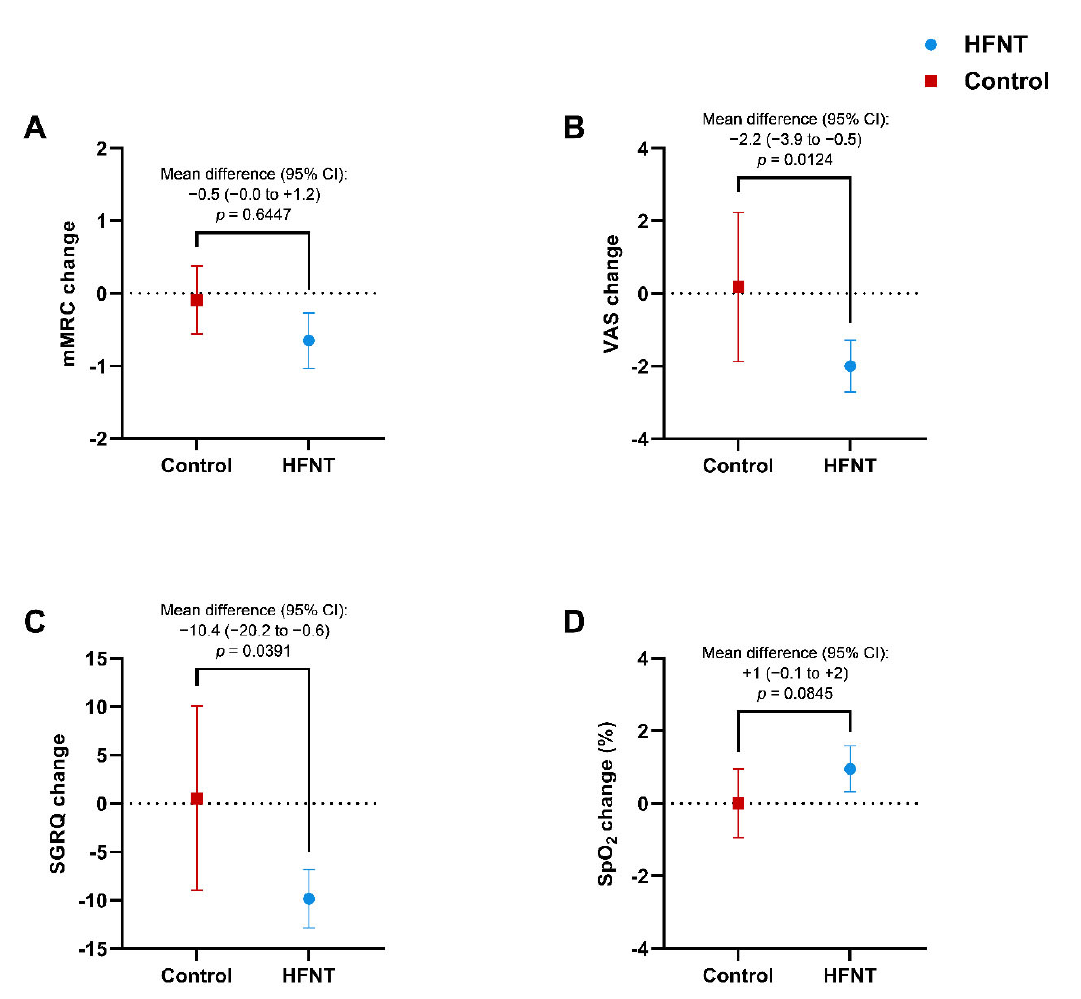
Figure 3. Changes in mMRC dyspnea scale ( A ), difficulty of expectoration (VAS) ( B ), SGRQ total score ( C ), and SpO 2 at rest ( D ) in HFNT and control group at baseline and after 12 months. Data are expressed as mean (95% CI). Abbreviations: HFNT, high-flow nasal therapy; mMRC, modified medical research council; VAS, visual analog scale; SGRQ, Saint George Respiratory Questionnaire; SpO 2 , peripheral blood oxygen saturation; CI, confidence intervals.